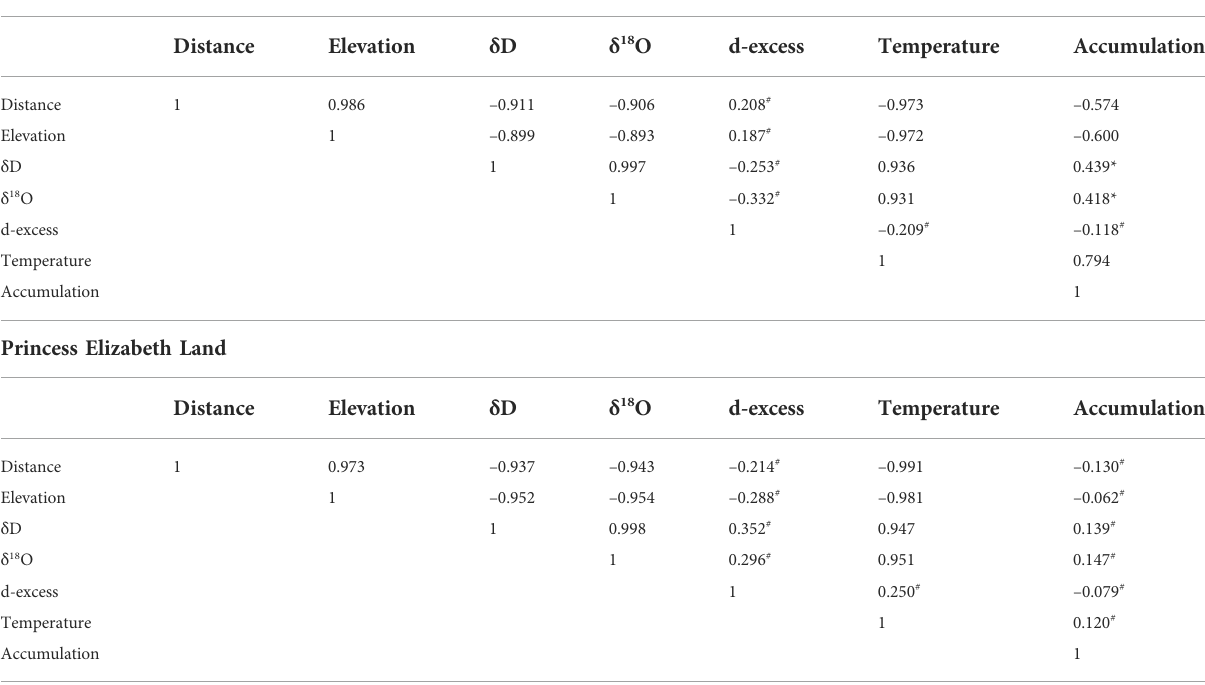
TABLE3CorrelationbetweenstableisotopesandphysicalparametersinDMLandPELregions.Allunmarkedcorrelationsaresigni fi cantat0.01level; # indicates insigni fi cant correlations and * indicates 0.05 level signi fi cance. Dronning Maud